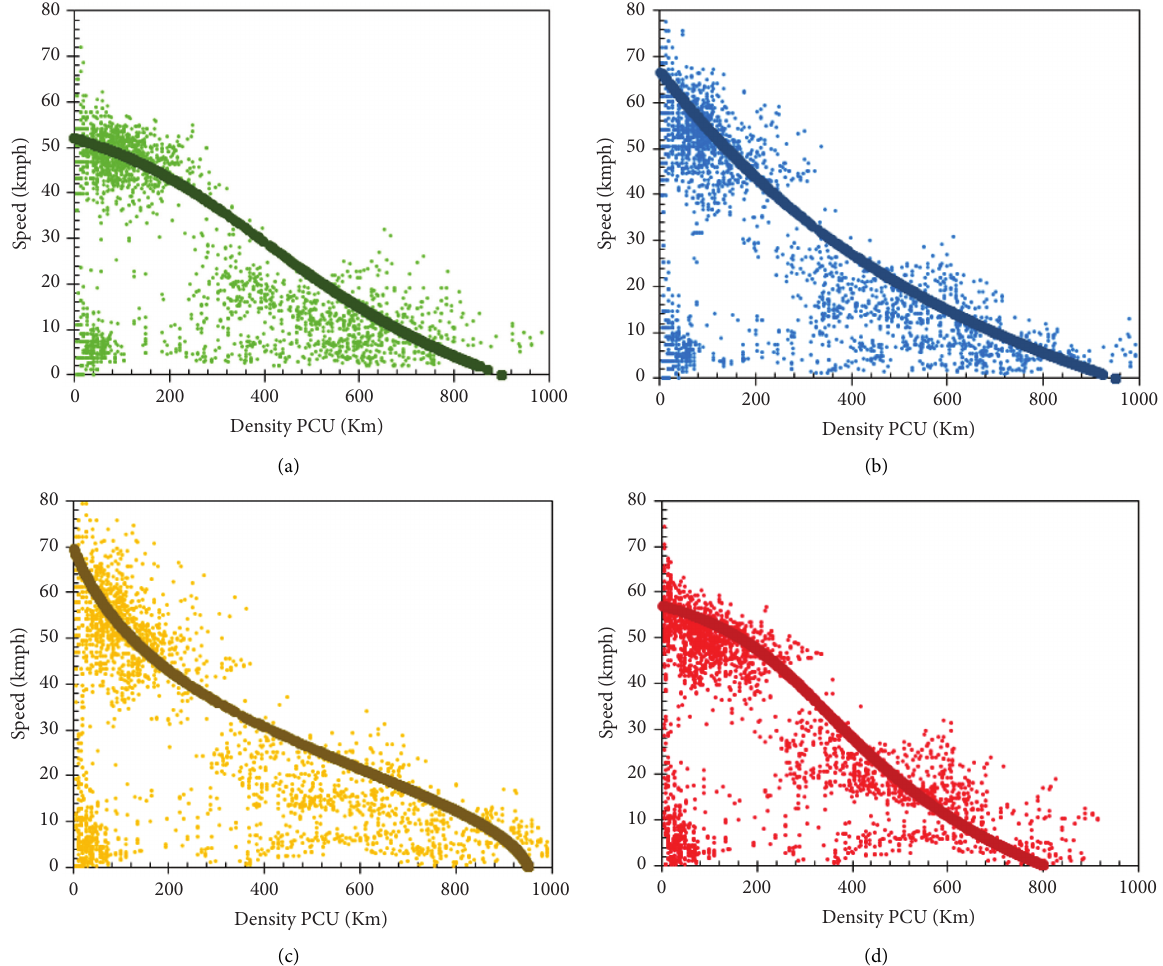
Figure 8: Macroscopic speed-density plots from different algorithms. (a) k-NN. (b) Random forest. (c) Regression tree. (d) Deep